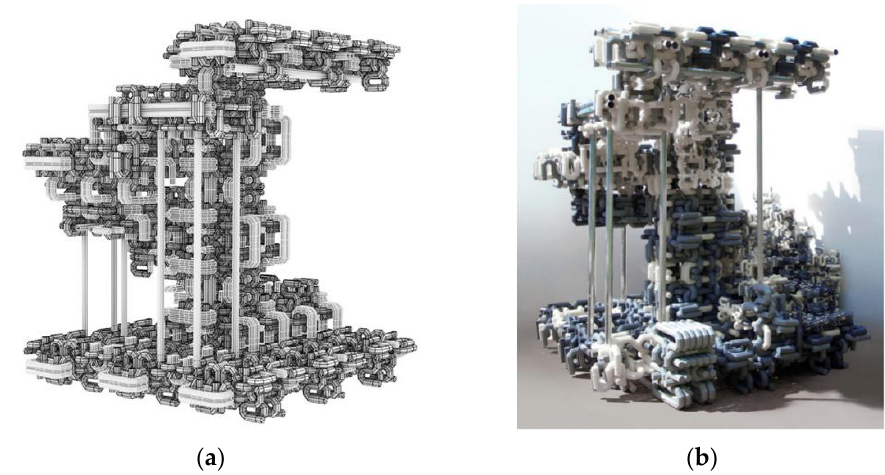
Figure 2. ( a ) 3D effect diagram of a proposed SUP structural unit and ( b ) its final physical construction result. Reprinted with permission from Ref. [3] © 2021, Chen*, Wang and Chen.